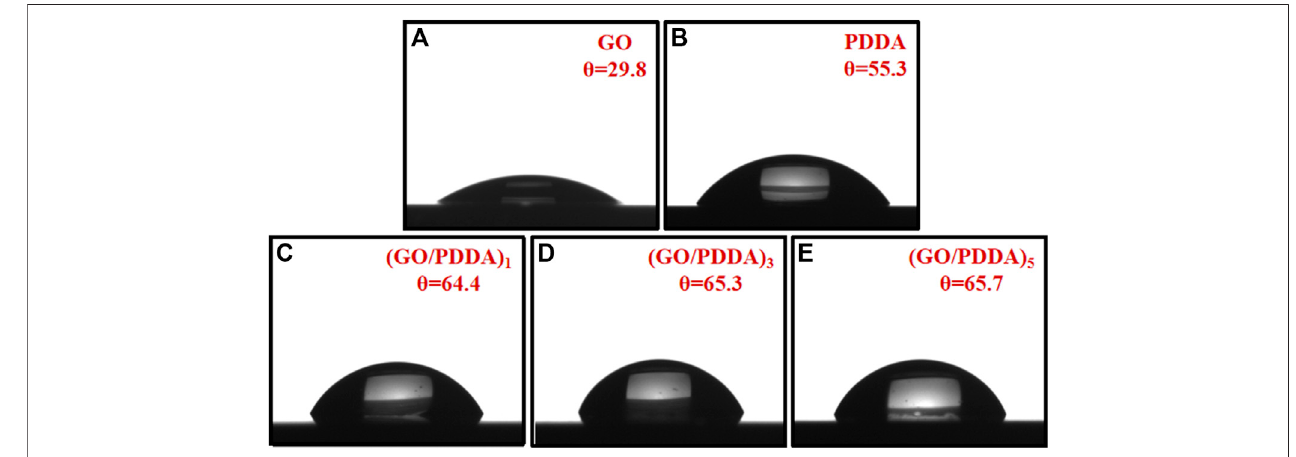
FIGURE 2 | Water contact angles (WCA) of composite fi lms.